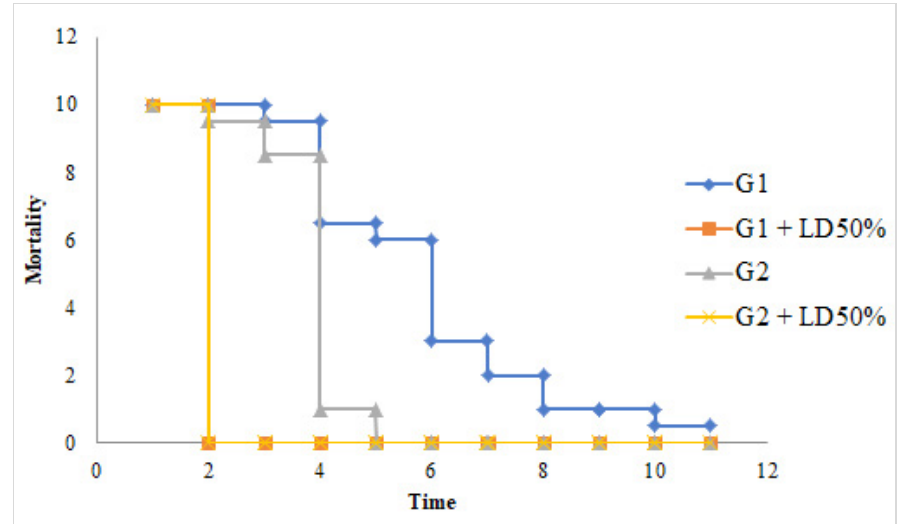
Fig 1 . Survival Curve of Apis mellifera Africanized supplemented (G2) or not (G1) with 25% of crude protein and challenged or not with LD